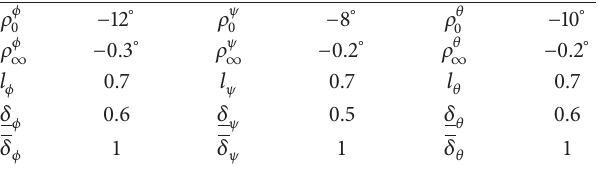
Figure 2: Neural network